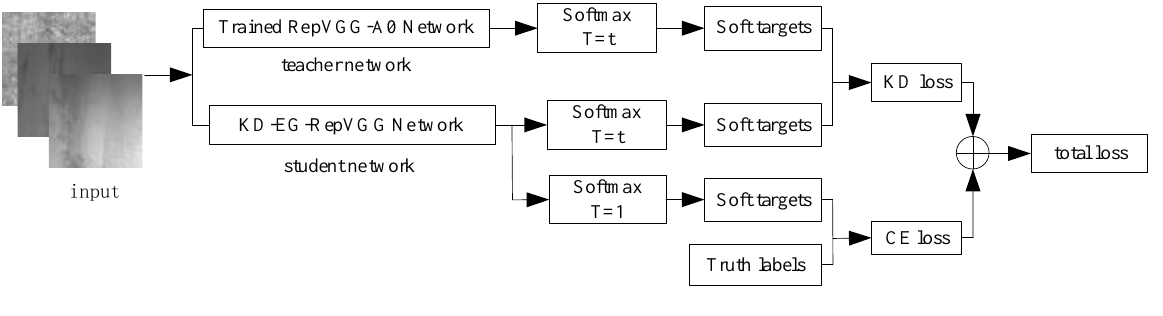
Figure 6. knowledge distillation procedure. Figure 6. Knowledge distillation